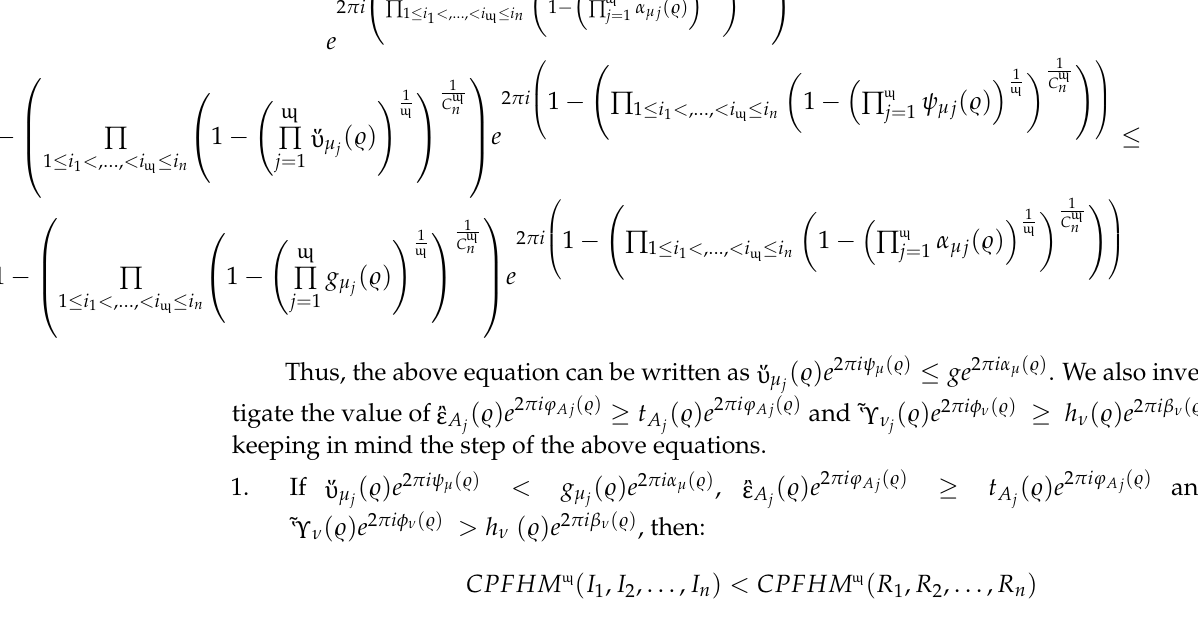
Table 1. Symbols and their meanings.